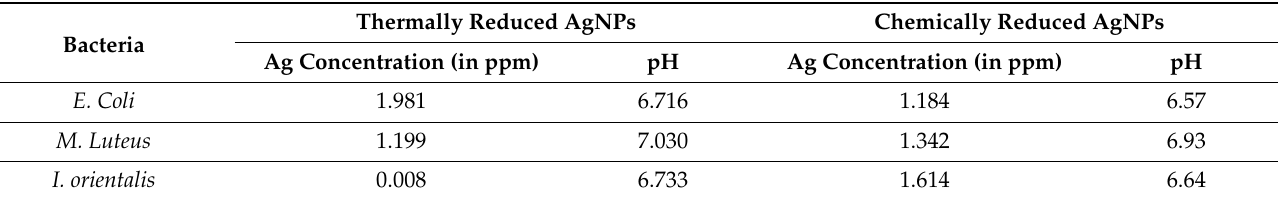
Table 1. Concentration of silver ions in lixiviated residues of the antimicrobial tests, with respective pH values. Adapted from [35]. Thermally Reduced AgNPs Chemically Reduced AgNPs Bacteria Ag Concentration (in